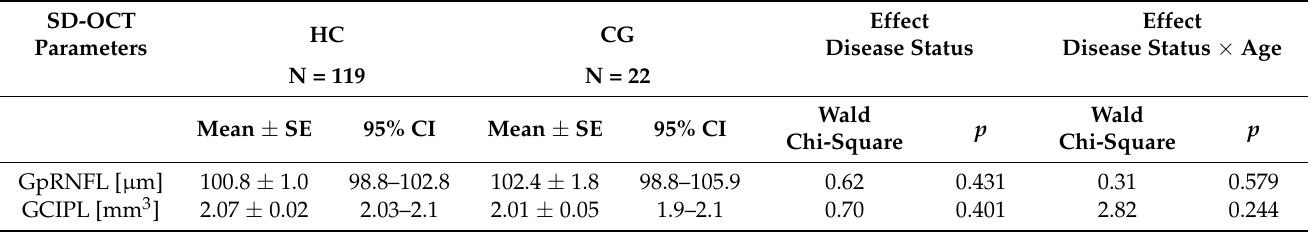
Table 2. Optical coherence tomography findings of classical galactosemia patients compared to healthy controls.